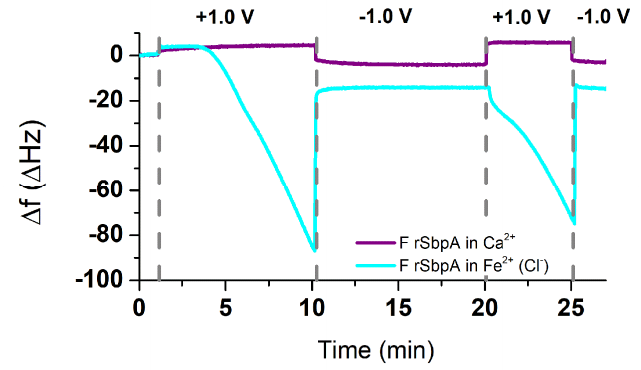
Figure 4. Fe-SbpA crystalline film electrical responsiveness. EQCMD measurements allow monitoring the real time ∆ f variation upon potential shifts between oxidation (+1 V) and reduction ( − 1 V) inducing conditions. A calcium-containing S-layer was used as negative control. 0.1 M HEPES was employed as running buffer.